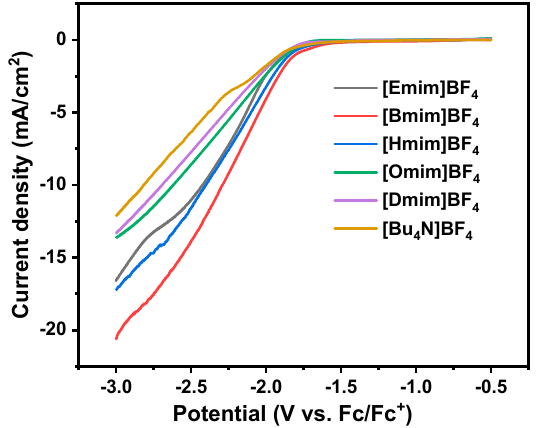
Figure 2. Linear sweep voltammograms (LSV) curves in CO 2 -saturated propylene carbonate (PC) solution of ionic liquids (ILs) and [Bu 4 N]BF 4 .